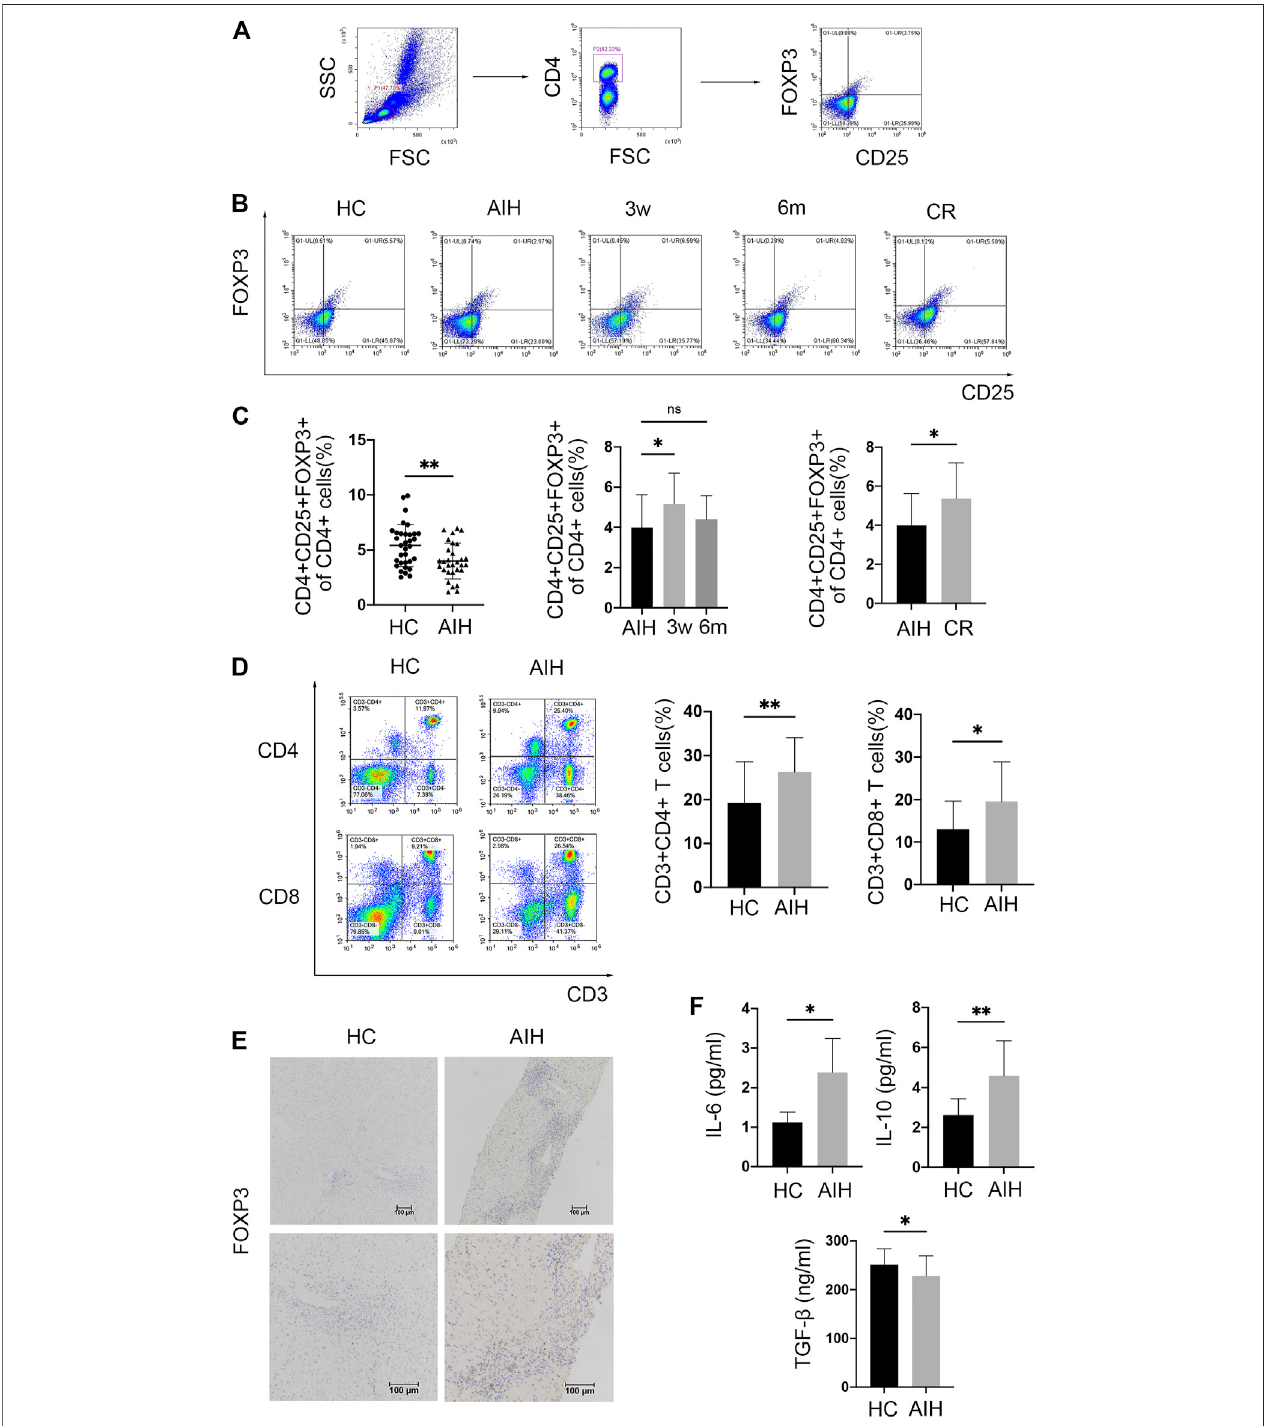
FIGURE 1 | Tregs were decreased in the peripheral blood but accumulated in the liver of AIH patients. (A) Gating strategy for circulating CD4+ CD25+ FOXP3+ Tregs. (B) Representative FCM plots showing Tregs in healthy donors (HCs), newly diagnosed AIH patients (AIH), patients receiving therapy (3 weeks and 6 months), and patients in complete biochemical remission (CR). (C) FCM analysis of circulating Tregs in HCs and AIH patients at diagnosis, during therapy, and in CR. (D) FCM analysisofcirculating CD3+ CD4+ Tcells and CD3+CD8+ Tcells inHCs and AIH patients. (E) Immunohistochemical staining forFOXP3 in liversamplesfrom HCs and AIH patients. (F) Serum levels of IL-6 and TGF- β measured by ELISA. Original magni fi cation, 100x and 200x.